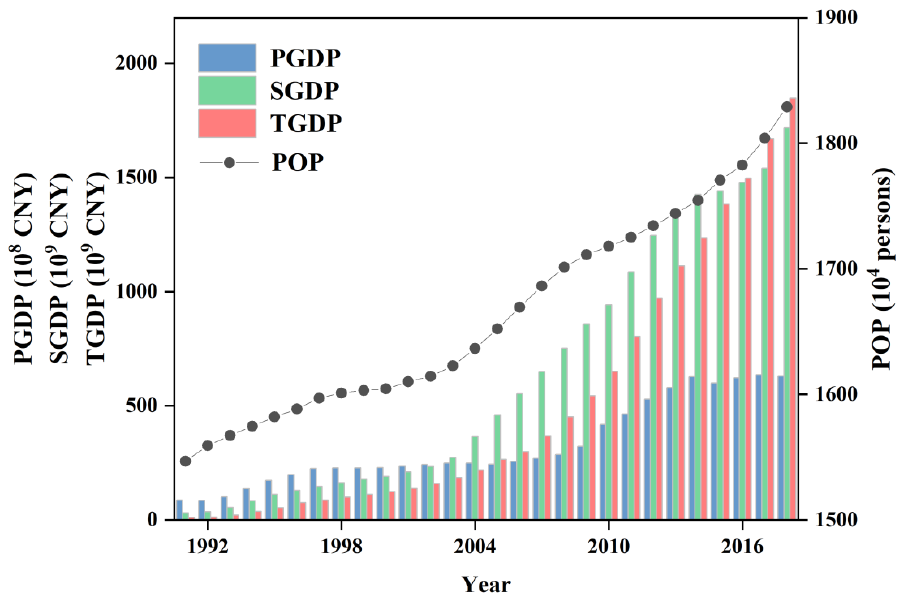
Figure 12. The POP, PGDP, SGDP, and TGDP in the surrounding cities of Taihu Lake.